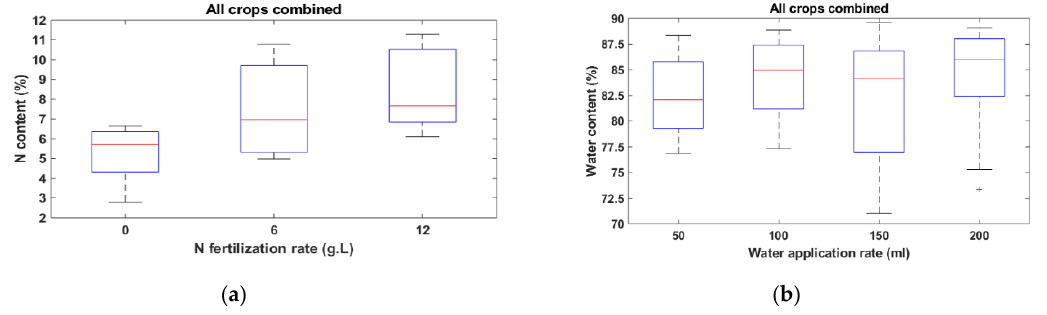
vertical axis represents the N content for ( a ) and water content for ( b ).